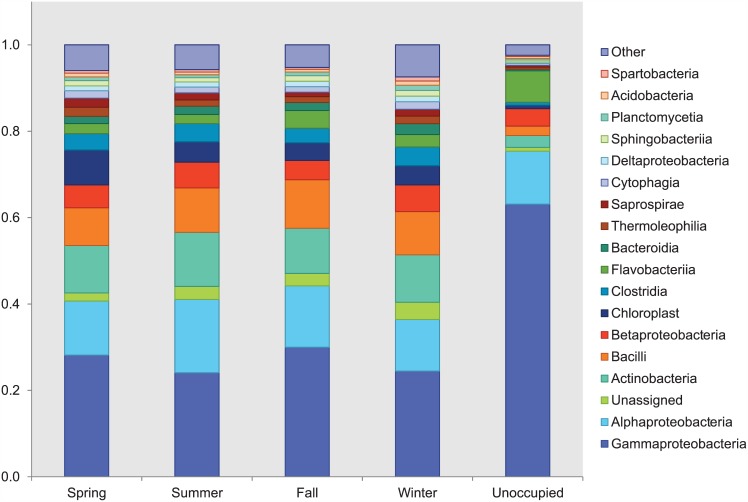
Phylogenetic classifications to the class level by season and when the center was unoccupied.